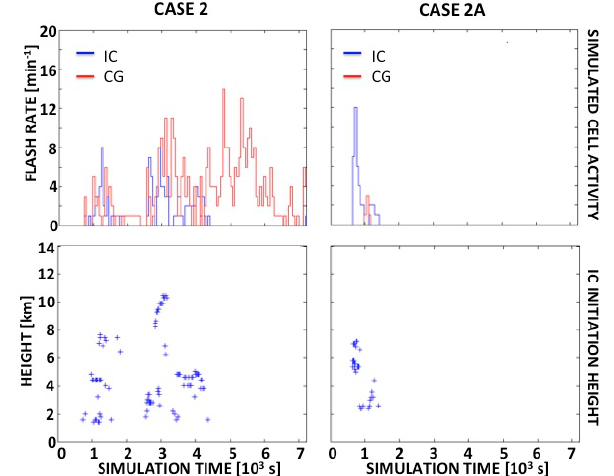
Fig. 15. Comparison between the evolution of the simulated grau- pel mixing ratio and lightning activity (top panels) and rain mixing ratio (bottom panels) for Case 2 (left column) and Case 2A (right column). The charging zone is delimited by the dotted red and blue horizontal lines. In top panels the ICs are marked as red crosses at the height where they initiate, and the CGs as green crosses at the surface. Finally, note that the results for the control run (Case 2) have been already shown in Fig. 13 and are duplicated here for con-